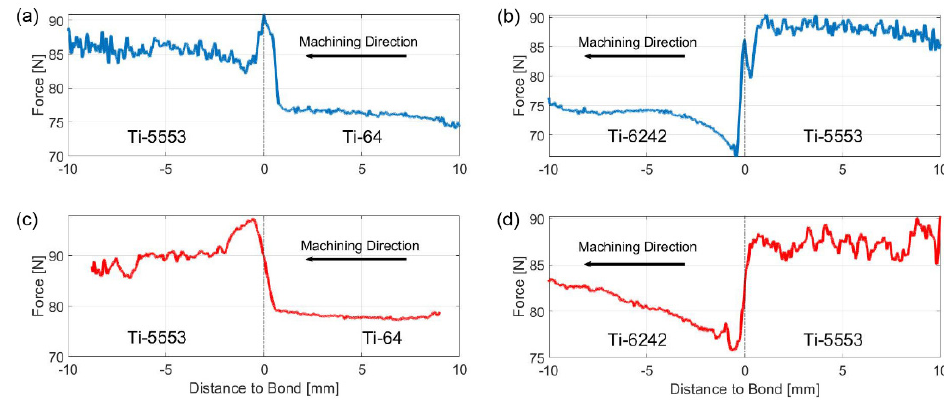
Figure 12. Plot of the forces generated in the machining operation of a FAST diffusion bonded sample made of Ti-5553 with Ti-64 and Ti-6242. ( a , b ) machined with a WFL M100 Millturn, ( c , d ) machined with a MAG Hawk 300 Lathe.